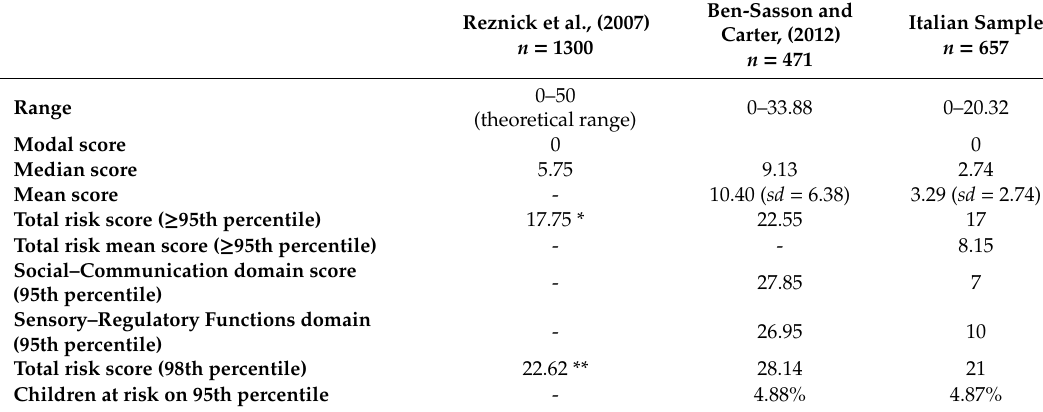
Table 5. Comparison between the American, Israeli and Italian cuto ff